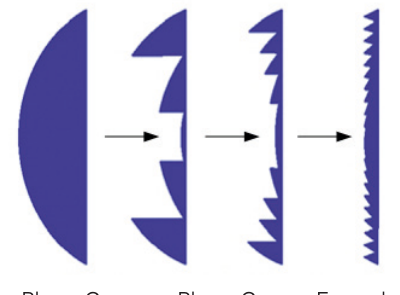
Plano-Convex ≈ Plano-Convex Figure 10. Plano-Convex Fresnel lens